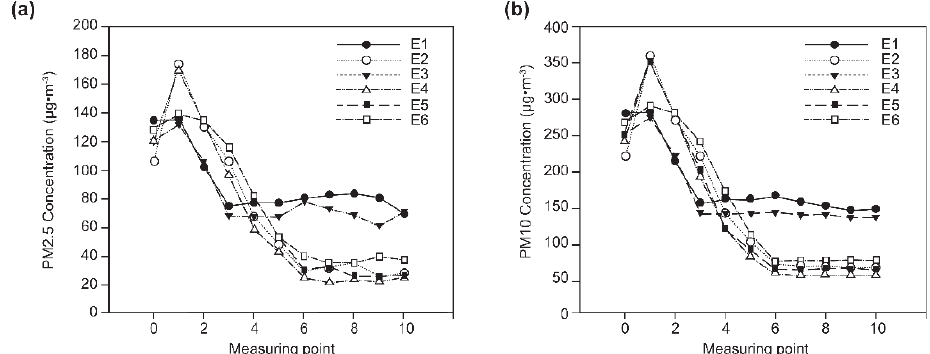
Figure 7. Changes in the PM concentration at the breathing height according to the type of vegetation configuration along an eight-lane road: ( a ) PM 2.5 and ( b ) PM 10 . The measurement point was set up at the leeward sidewalk based on the central point of the road. Point 0 is the center of the road, Points 6 and 7 are the starting and ending points of the vegetation area, respectively, and Point 9 is the center of the sidewalk. Points 0–6, 6–7, and 7–10 are the road, vegetation area, and sidewalk, respectively.